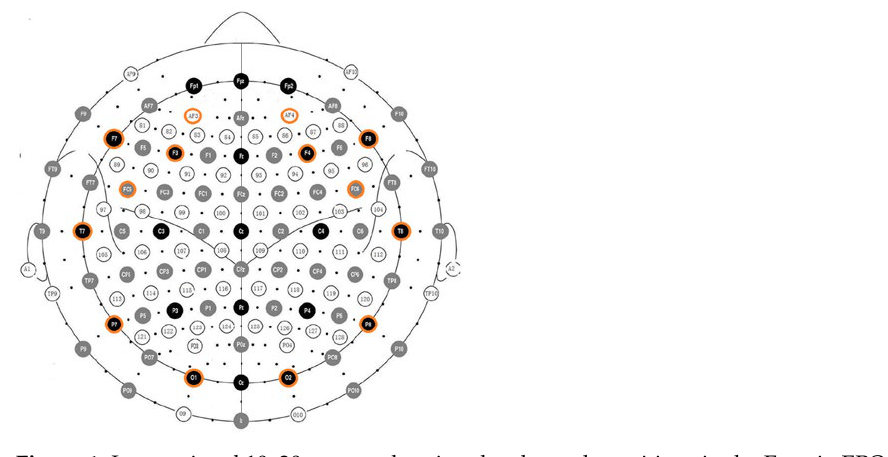
Figure 1. International 10–20 system showing the electrode positions in the Emotiv EPOC.